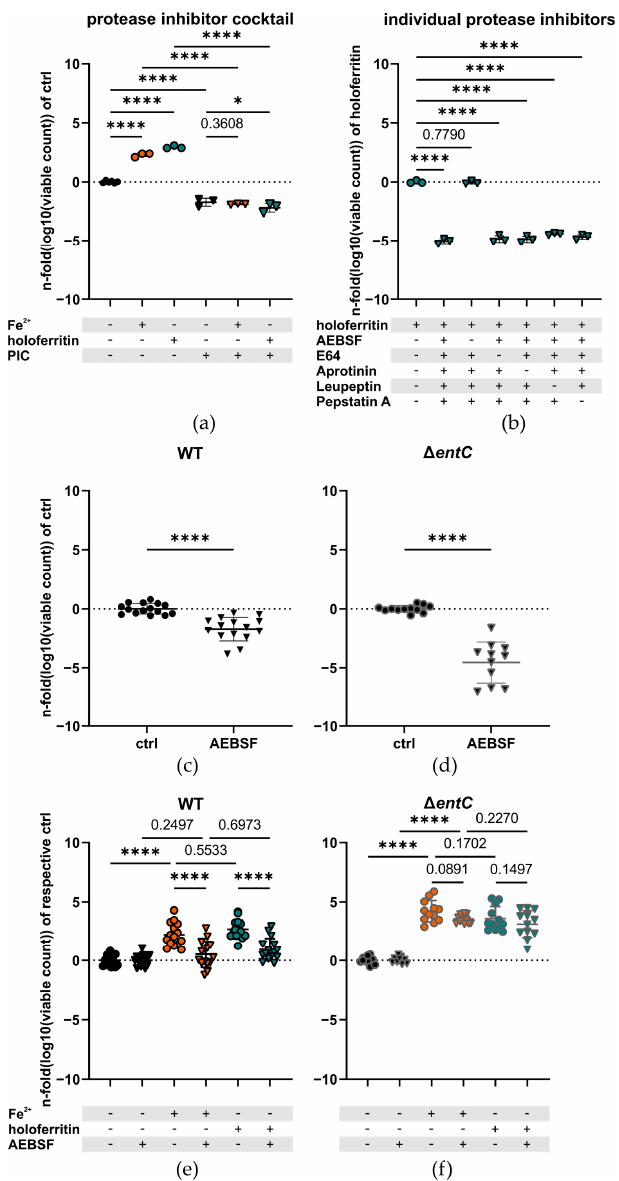
Figure 3. ( a ) Growth of S. Tm upon addition of a PIC (N = 3, n = 2). ( b ) Effect of the individual protease inhibitors of the PIC (excluding Bestatin hydrochloride, which was not available due to shortness of supplies, AEBSF: 346.67 µ M, E64: 4.67 µ M, Aprotinin: 0.27 µ M, Leupeptin: 6.67 µ M, Pepstatin A: 5 µ M), on the growth of S. Tm with 5 µ M of ferritin-bound iron (N = 3, n = 1). Growth of ( c ) WT S. Tm (N = 15, n = 5) and ( d ) the ∆ entC strain upon addition of AEBSF to the medium (N = 12, n = 4). Growth of ( e ) the WT strain (N = 15, n = 4) and ( f ) the ∆ entC mutant (N = 12, n = 4) upon addition of ferrous or ferritin bound iron with or without AEBSF (triangles and circles, respec- tively). ( a , b ) were conducted in ambient air and ( c – f ) were conducted in 5% O 2 , 5% CO 2 atmosphere. Growth data were logarithmized and then normalized to ( a , c , d ) the iron free control, ( b ) supplementa- tion with 5 µ M of ferritin-bound iron, or ( e , f ) their corresponding controls: no supplement (circles) or AEBSF (triangles), to account for the iron-independent growth inhibition of AEBSF. Graphs are depicted as mean ± SD. For statistical analysis, either Student’s t-test ( c , d ) or one-way ANOVA ( e , f ) corrected for multiple comparisons, and the Holm-Sidak post hoc test was also used (*: p < 0.05; ****: p < 0.0001, numbers indicate a non-significant p -value > 0.05). N: number of biological replicates, n: number of experiments conducted, PIC: protease inhibitor cocktail, WT: wildtype S. Tm, ∆ entC : S. Tm enter- obactin/salmochelin knockout mutant strain, AEBSF: 4-(2-Aminoethyl)benzenesulfonyl